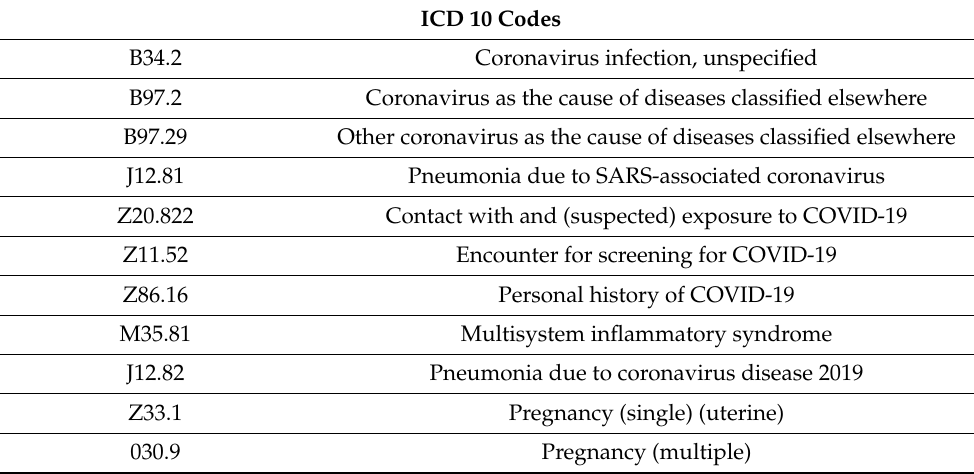
Table 1. ICD-10 Pregnancy and COVID-19 codes used to identify charts for